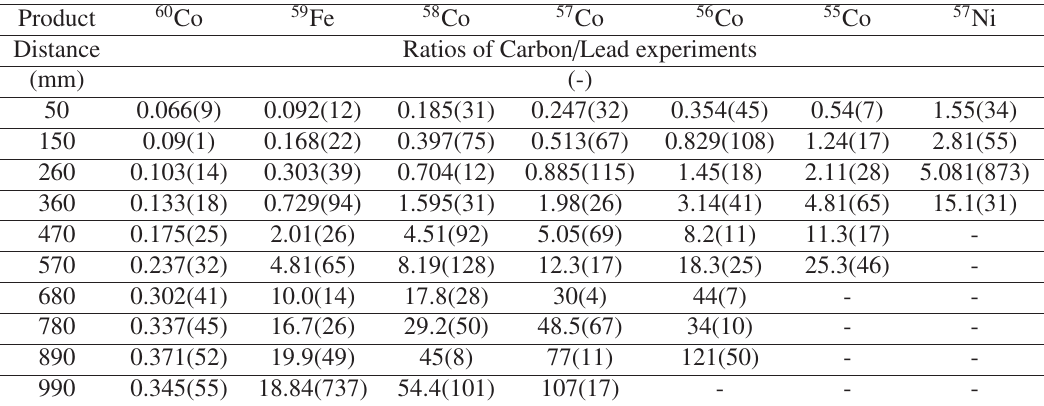
Table 1. Ratios of produced reaction rates of 59 Co ( n ,γ ) 60 Co , 59 Co ( n , p ) 59 Fe , 59 Co ( n , 2 n ) 58 Co , 59 Co ( n , 3 n ) 57 Co , 59 Co ( n , 4 n ) 56 Co , 59